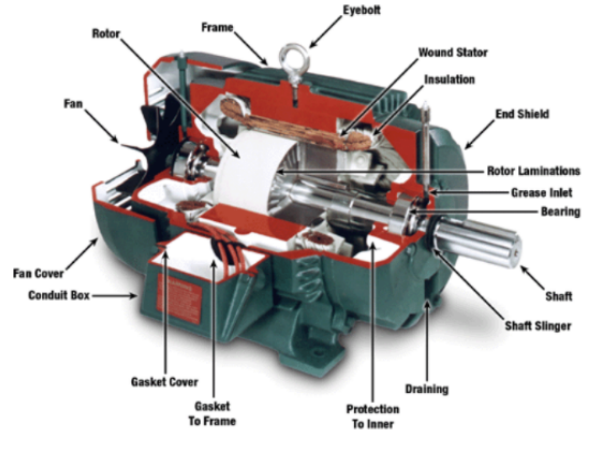
Figure 3: Typical construction of an induction ma-